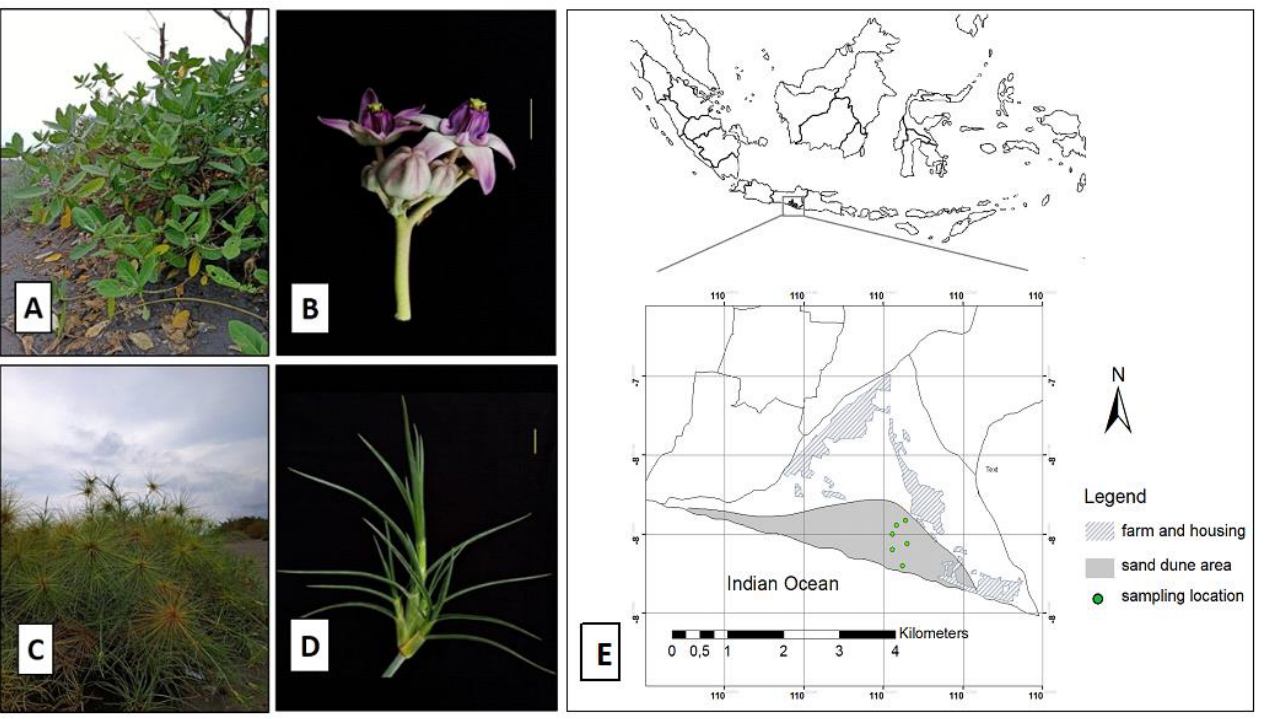
Figure 1. Halophyte habitats and sampling locations. ( A ) Calotropis gigantea at Parangkusumo sand dune and ( B ) its flowering part. ( C ) Spinifex littoreus at Parangkusumo sand dune and ( D ) its leaf morphology. ( E ) Six sampling locations across Parangkusumo sand dune area.